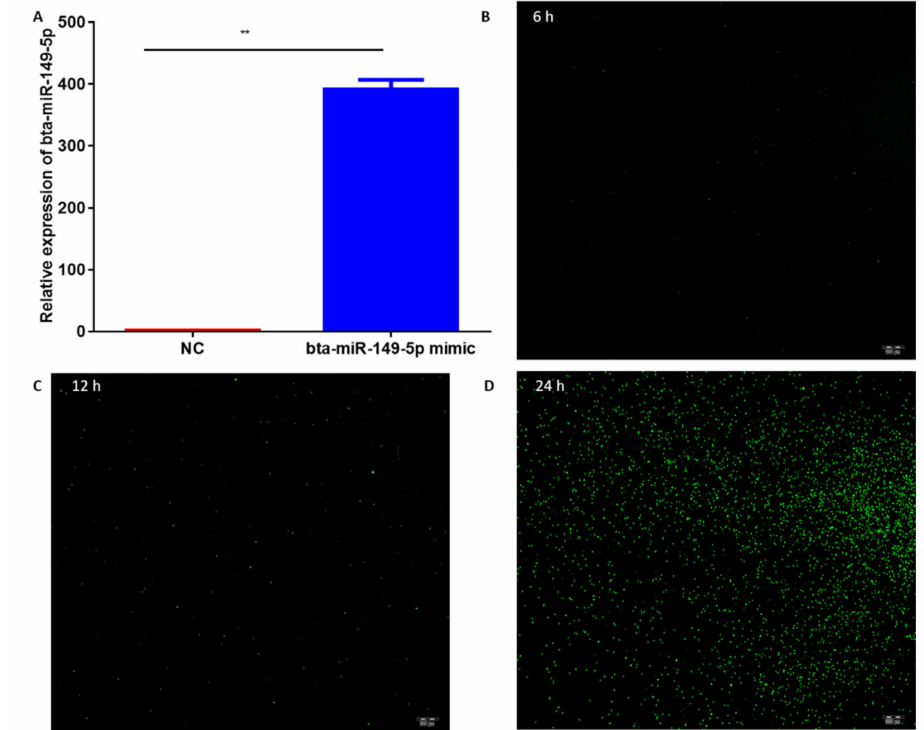
Figure 1. Transfection and interference efficiencies of miR-149-5p: ( A ) qPCR results showing expression levels of bta-miR- 149-5p in adipocytes transfected with bta-miR-149-5p mimic and its negative control. ( B – D ) Transfection efficiency was checked through FAM/labeled miR-NC in bovine adipocytes; after 6-, 12-, and 24-h intervals, the transfection efficiency was measured through an Olympus I × 71 microscope (OLYMPUS) in bovine adipocytes. U6 was used as a house- keeping gene, and the relative expression level in adipocytes transfected with bta-miR-149-5p mimics was normalized with adipocytes transfected with mimic NC. The values presented with mean ± SEM, n = 3, and ** p < 0.01 were considered statistically